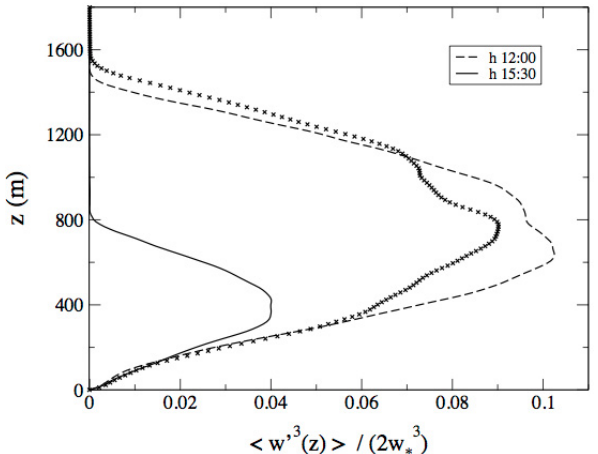
Fig. 13. The evolution of the vertical velocity variance flux in the LES with subsidence and in the control case. The dashed line is from the LES run before turning on the subsidence; the continu- ous line is at 15:30UTC in the run with subsidence; the curve with crosses is from the control run, without